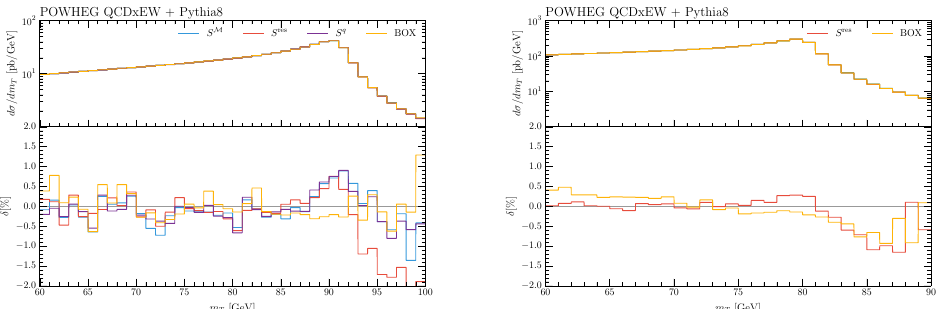
Figure 5 : Transverse-mass distribution for the neutral-current (left) and charged-current (right) Drell-Yan processes. We show the di(cid:11)erential cross section (top) and the relative corrections (bottom) with respect to the results obtained using S def for S res , S M , S q , and the Powheg-Box